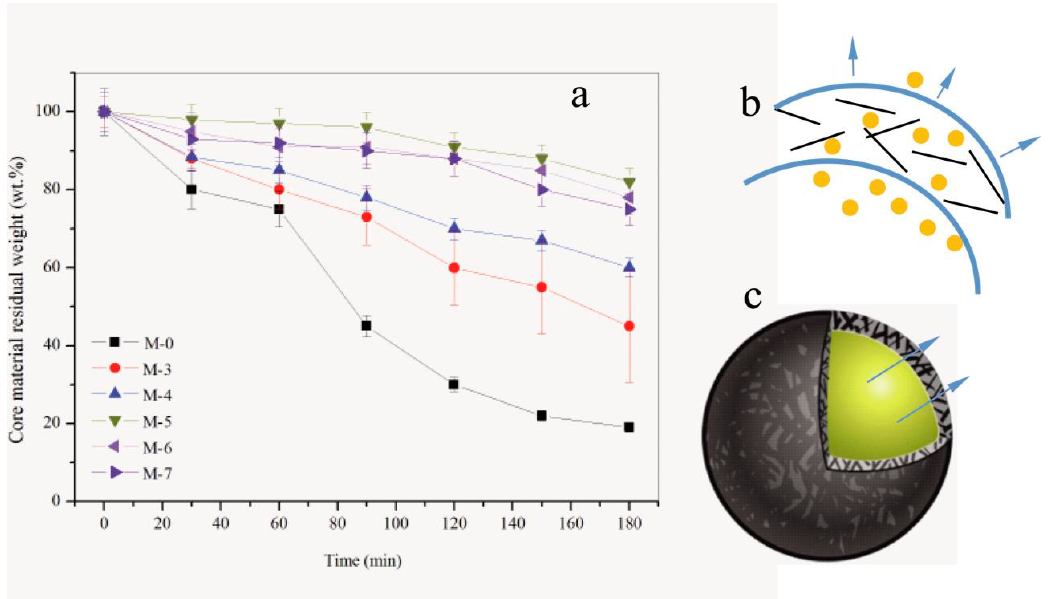
Figure 16. Compactability of shells of microcapsule samples, ( a ) release curves of M-0, M-3, M-4, M-5, M-6, M-7 in alcohol during 180 min, ( b ) the illustration of core material pass through the shell with graphene, and ( c ) the core-shell illustration of a microcapsule.